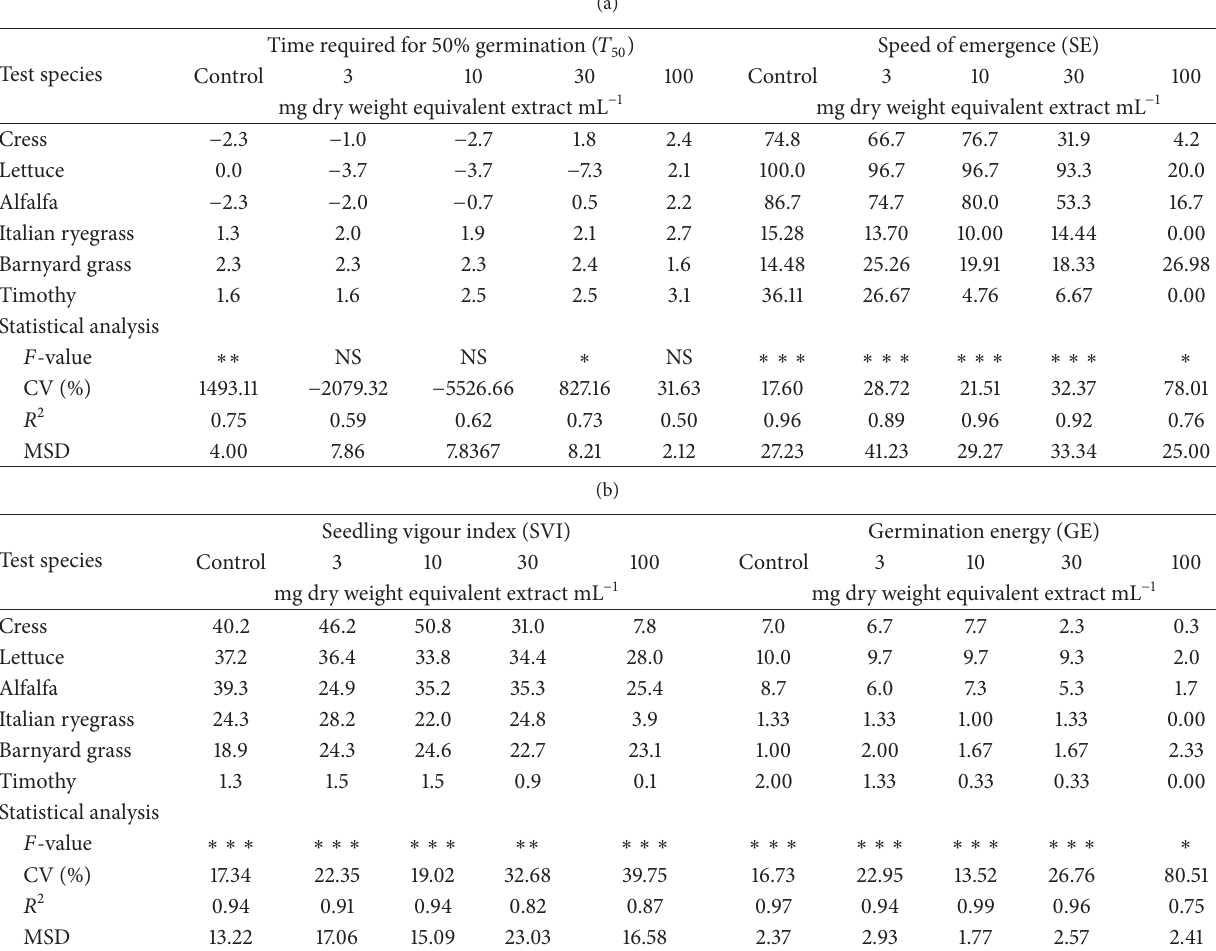
Table 2: (a) Effects of aqueous methanol extracts of O . tenuiflorum on 𝑇 50 and SE of different plant species at four different concentrations. (b) Effects of aqueous methanol extracts of O . tenuiflorum on SVI and GE of different plant species at four different concentrations.